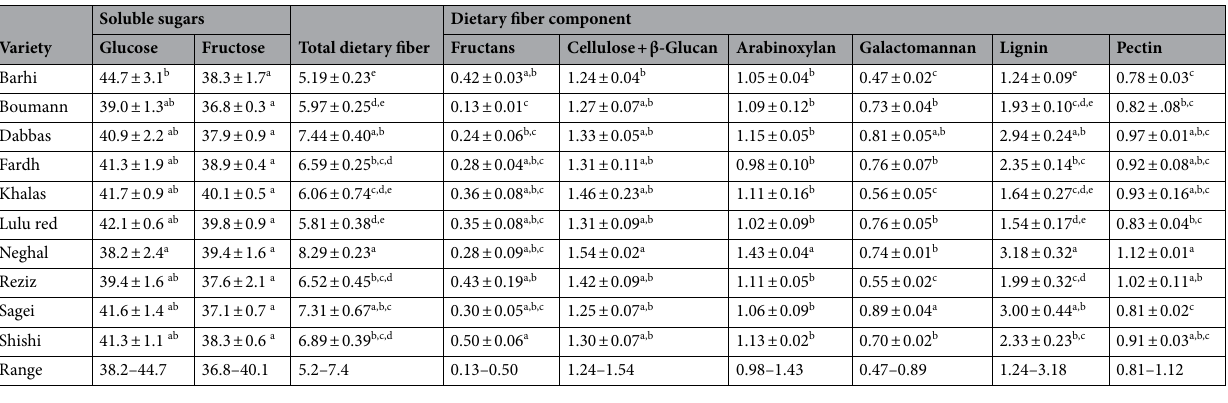
Table 1. Contents of soluble sugars, total dietary fiber, and dietary fiber components in 10 United Arab Emirates date fruit varieties (g/100 g dry weight). The value for each variety is the average of three samples collected at different locations in the UAE. The mean values ± standard deviation with different superscript letters within each column are statistically different (p <